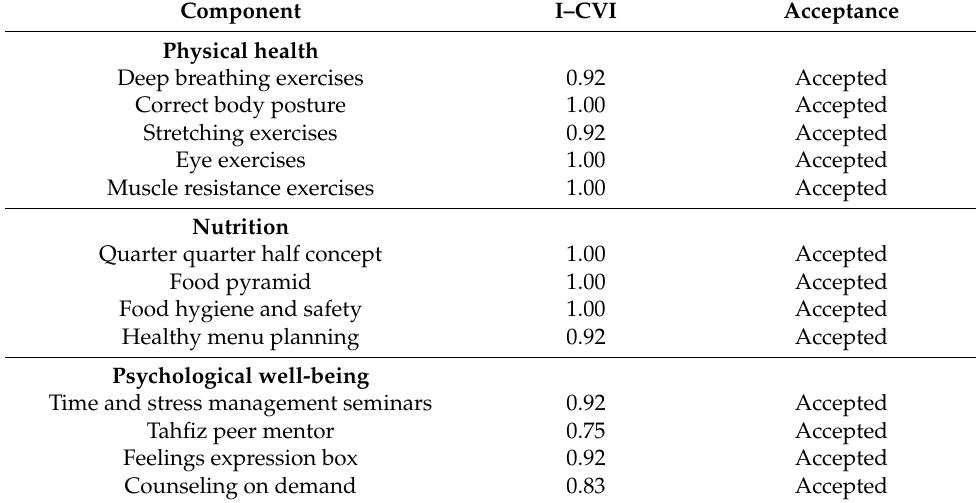
Table 5. Content validity index for each item of each component in the Huffaz ProHealth 1.0 © module.